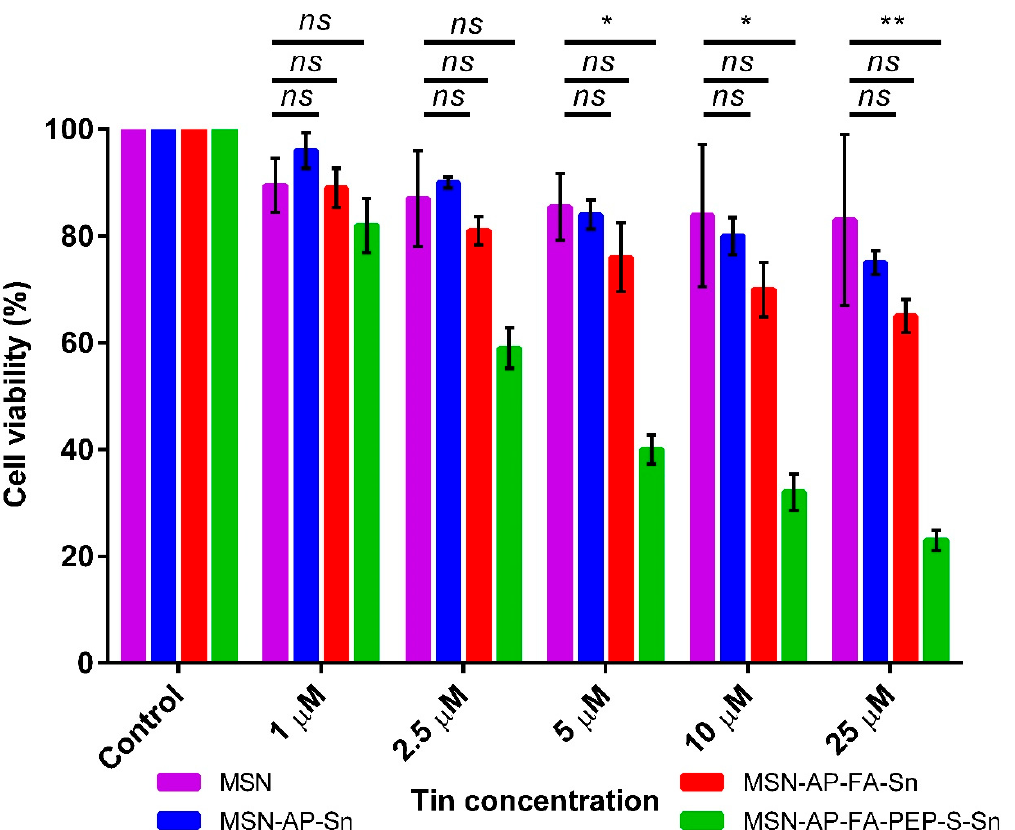
Figure 6. MTT viability assay of MDA-MB-231 cells after incubation with different concentrations of the MSN nanomaterials. All the results were expressed as % of control (mean ± SD, n = 3 independent experiments and 3 replicates/experiment). Significance was calculated by one-way ANOVA Tukey’s test. ns: p > 0.05 or not significant statistical difference between the groups of data; *: p < 0.05 or significant statistical difference between the groups of data; **: p < 0.01 or significant statistical difference between the groups of data.